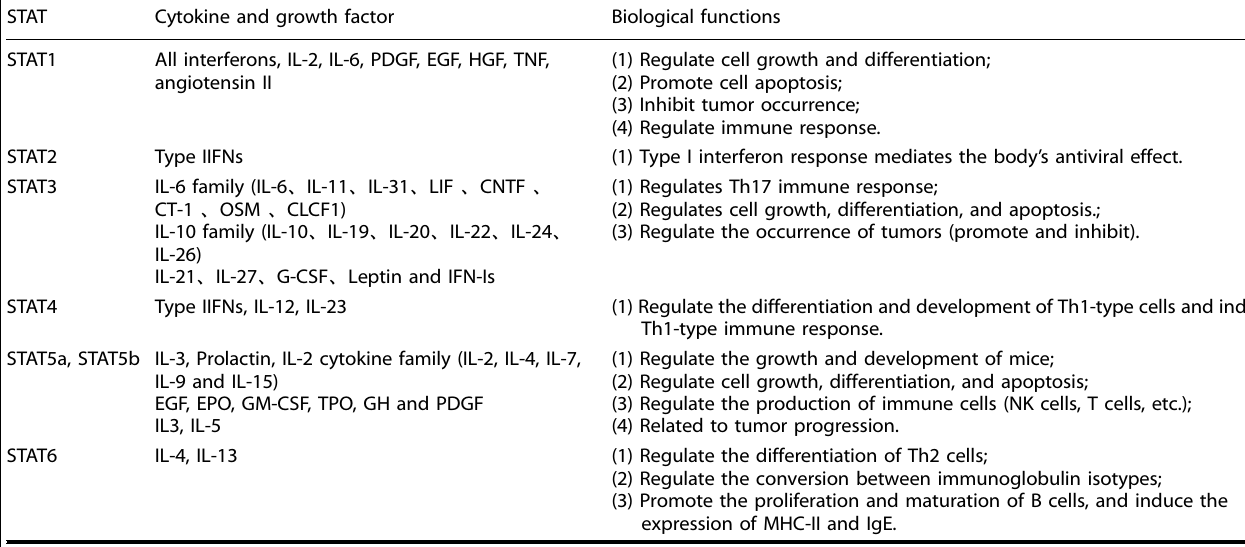
Table 2. Activated STAT family cytokines and growth factors and STAT-mediated biological functions STAT Cytokine and growth factor Biological functions